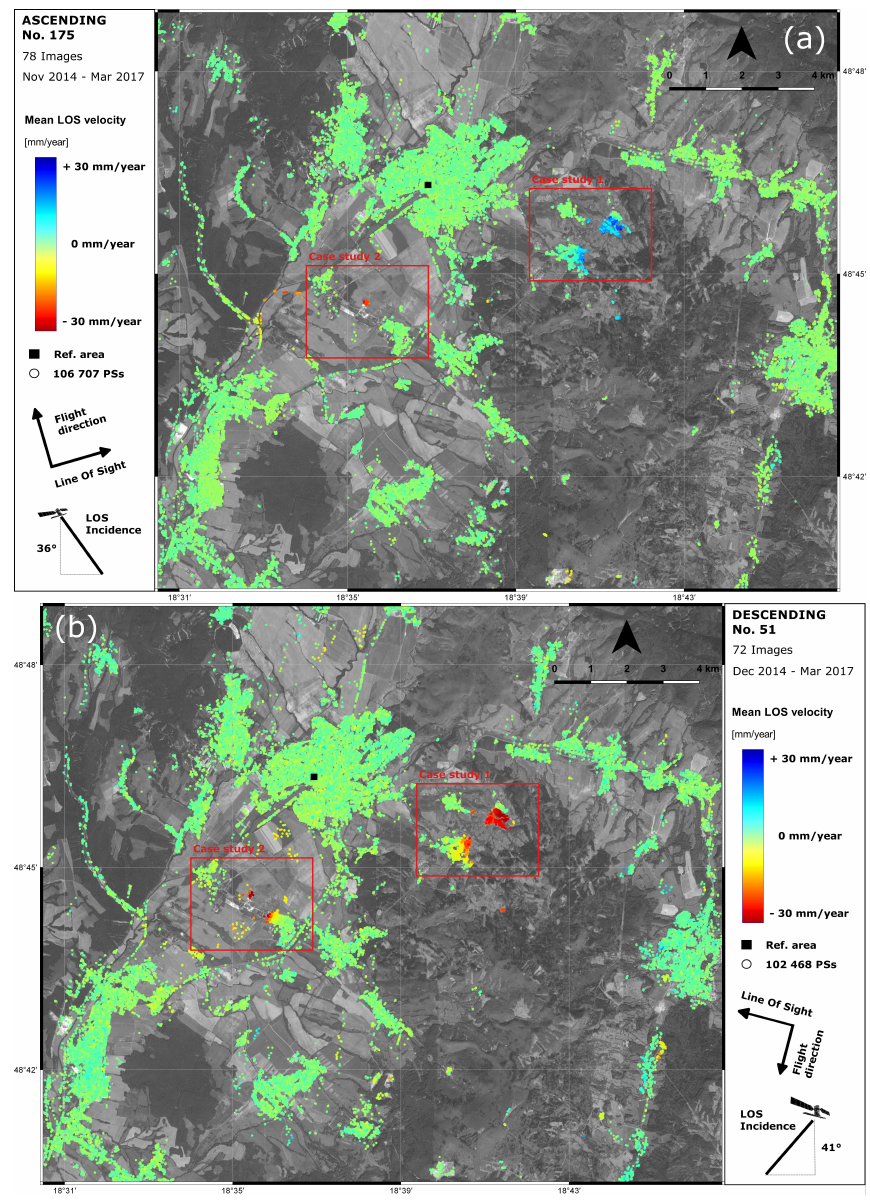
Figure 7. Mean line-of-sight (LOS) deformation velocity maps produced from ( a ) ascending and ( b ) descending Sentinel-1 stacks. Outlier elimination has already been performed. Red values indicate movement away from the satellite, whereas blue values indicate movement towards the